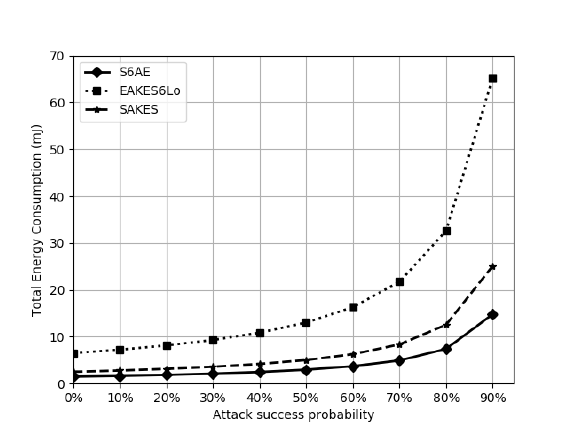
Figure 7. Energy consumption overhead.